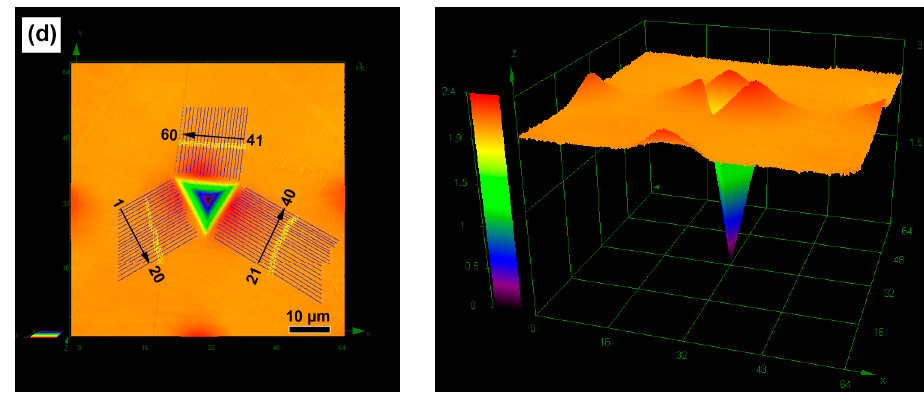
Figure 3. LCM images of 30 nm Cu ( a ); 150 nm Cu ( b ); 300 nm Cu ( c ); and CG Cu ( d ) obtained at a strain rate of 0.04/s and the indentation depth of 2000 nm. The left side gives the places where h pile-up is measured and the right gives the corresponding three-dimensional graphs.